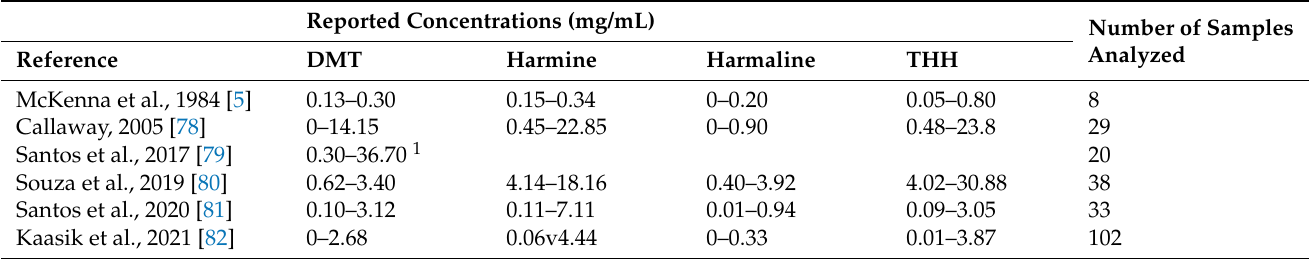
Table 2. Ayahuasca’s alkaloid concentration reported in studies with at least 8 different samples.